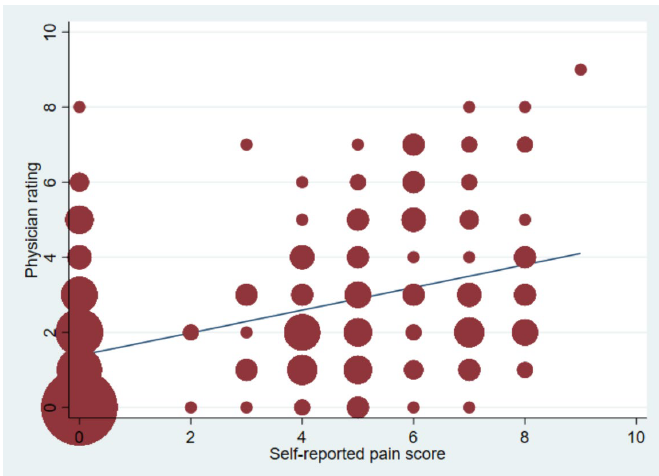
Figure 2. The scatterplot of self-reported pain scores and physicians’ ratings of pain. The line indicates the best-fit linear regression line. The sizes of circles are proportional to the number of